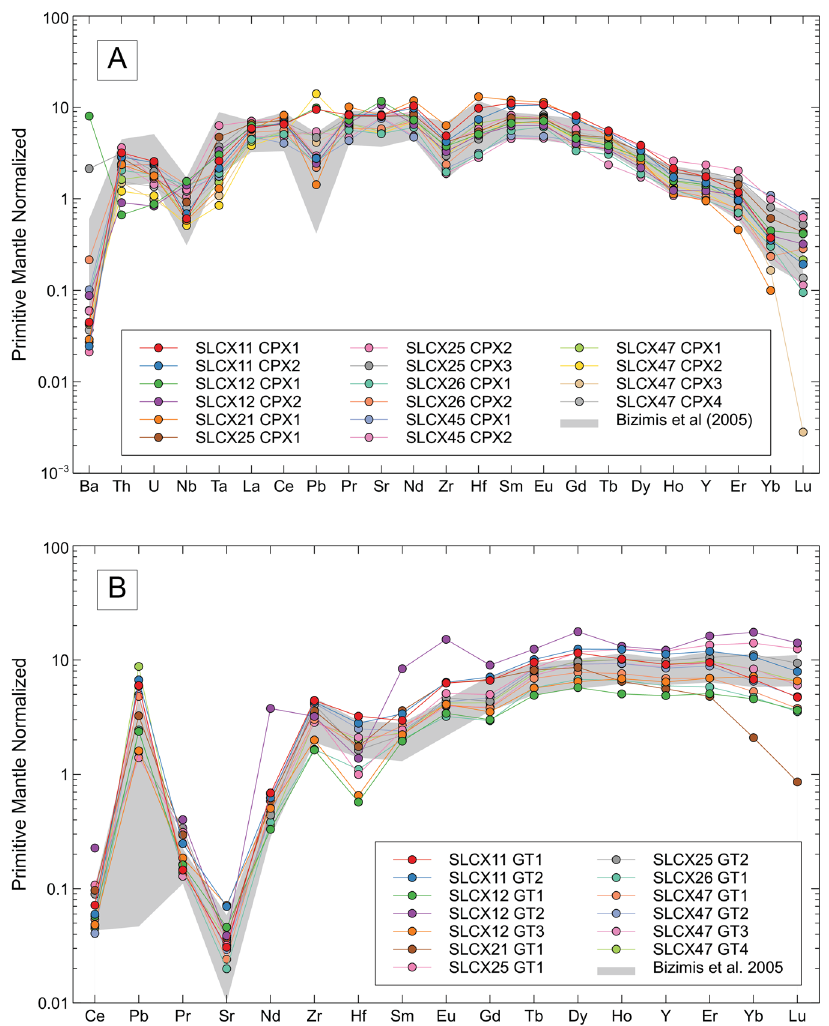
Fig. 2 Primitive mantle normalized diagrams for SLC pyroxenites. Diagram ( a ) is for clinopyroxene and ( b ) shows garnet from the SLC garnet pyroxenites including those that contained zircon (SLCX 12 and 47). Shaded fi elds show the range of clinopyroxene and garnet compositions reported for SLC garnet pyroxenites by Bizimis et al. 21 . Normalizing values from McDonough and Sun 62 and element order from Sun and McDonough 2